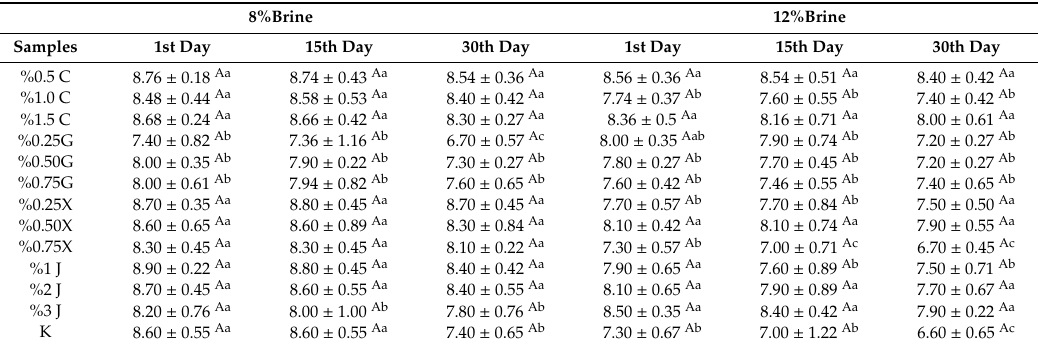
Table 15. Taste score of cheese samples during